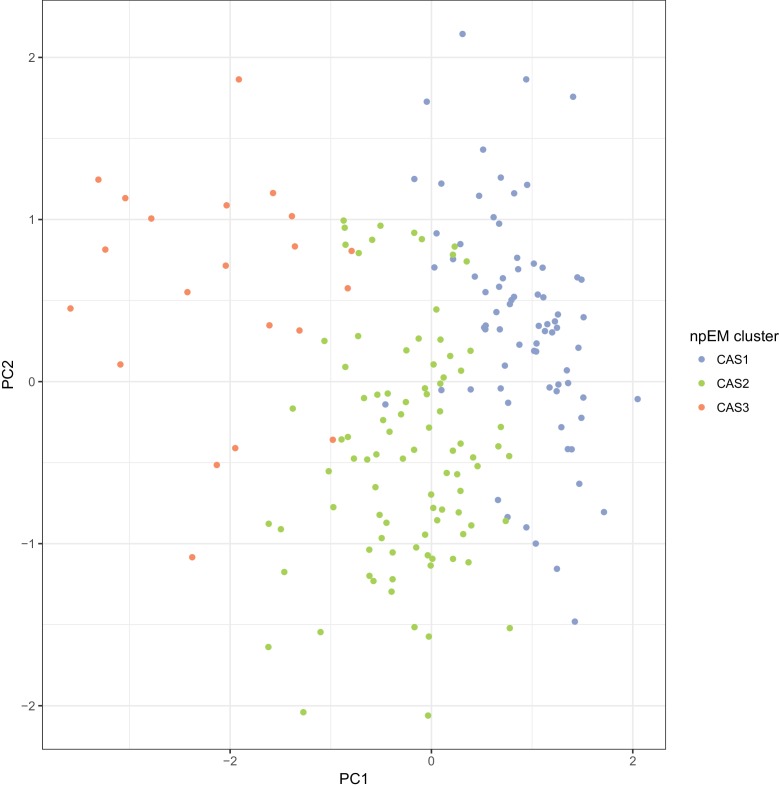
Scatterplot of principal components analysis (PCA) of the complete-case CAS dataset (N = 186), with points coloured by npEM clusters Each point represents an individual.The first two PCs (shown) account for 16.7% of the total variance.